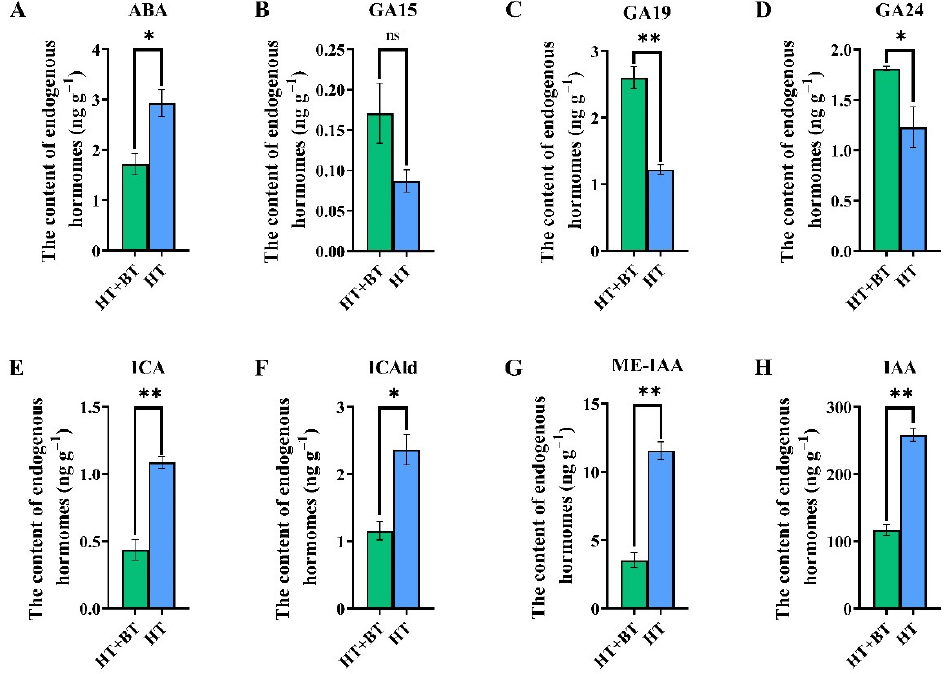
Figure 3. Comparison of hormone levels in HT- and HT + BT-treated seeds: ( A ) comparison of ABA content; ( B ) comparison of GA15 content; ( C ) comparison of GA19 content; ( D ) comparison of GA24 content; ( E ) comparison of ICA content; ( F ) comparison of ICAld content; ( G ) comparison of ME–IAA content; ( H ) comparison of IAA content. Each parameter * indicates significant statistical difference, * ( p < 0.05), ** ( p < 0.01).